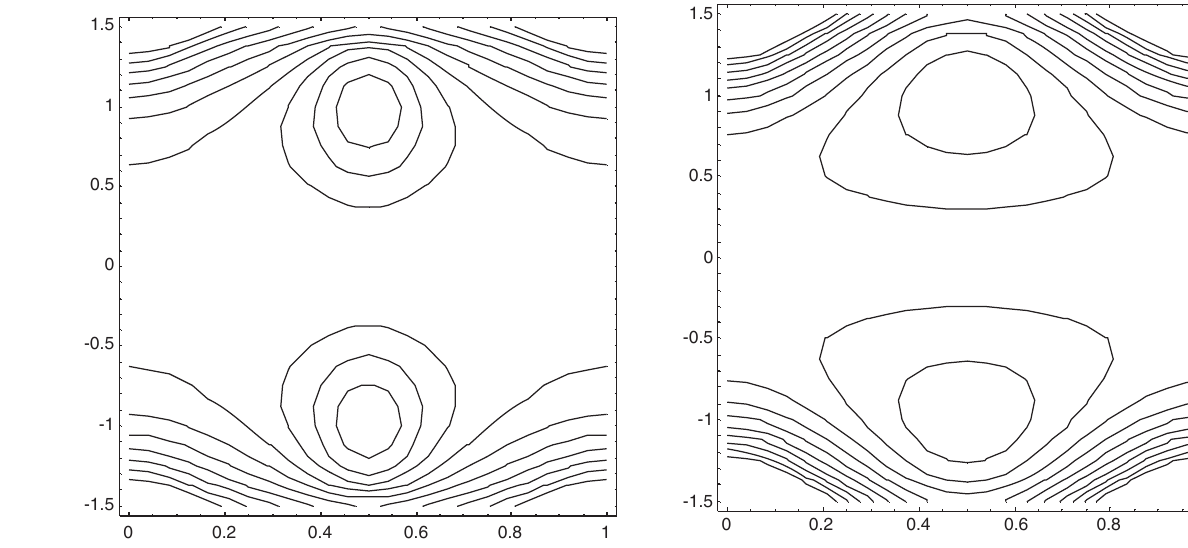
Fig. 19. Streamlines in the wave frame when Q =0.9, φ =0.6, M =1.0, N =0.75.